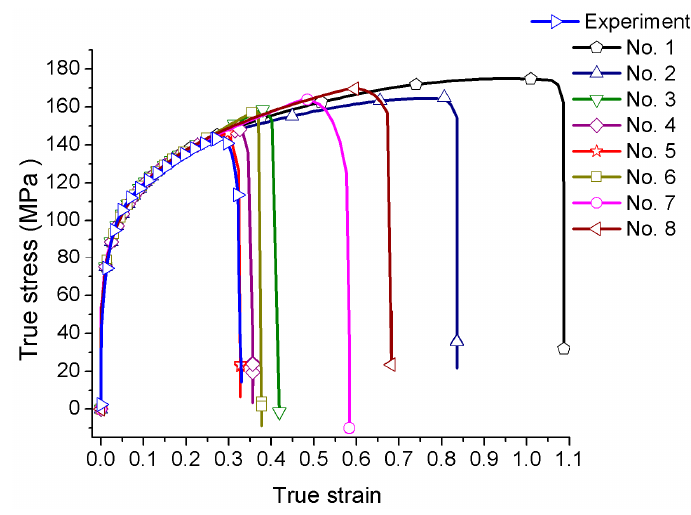
Figure 4. True stress strain curves of different parameters coupled with Gurson-Tvergaard-Needleman (GTN) damage model. Table 4. Standard deviation, critical strain and fracture strain under different parameters in Gurson-Tvergaard-Needleman (GTN) damage model.